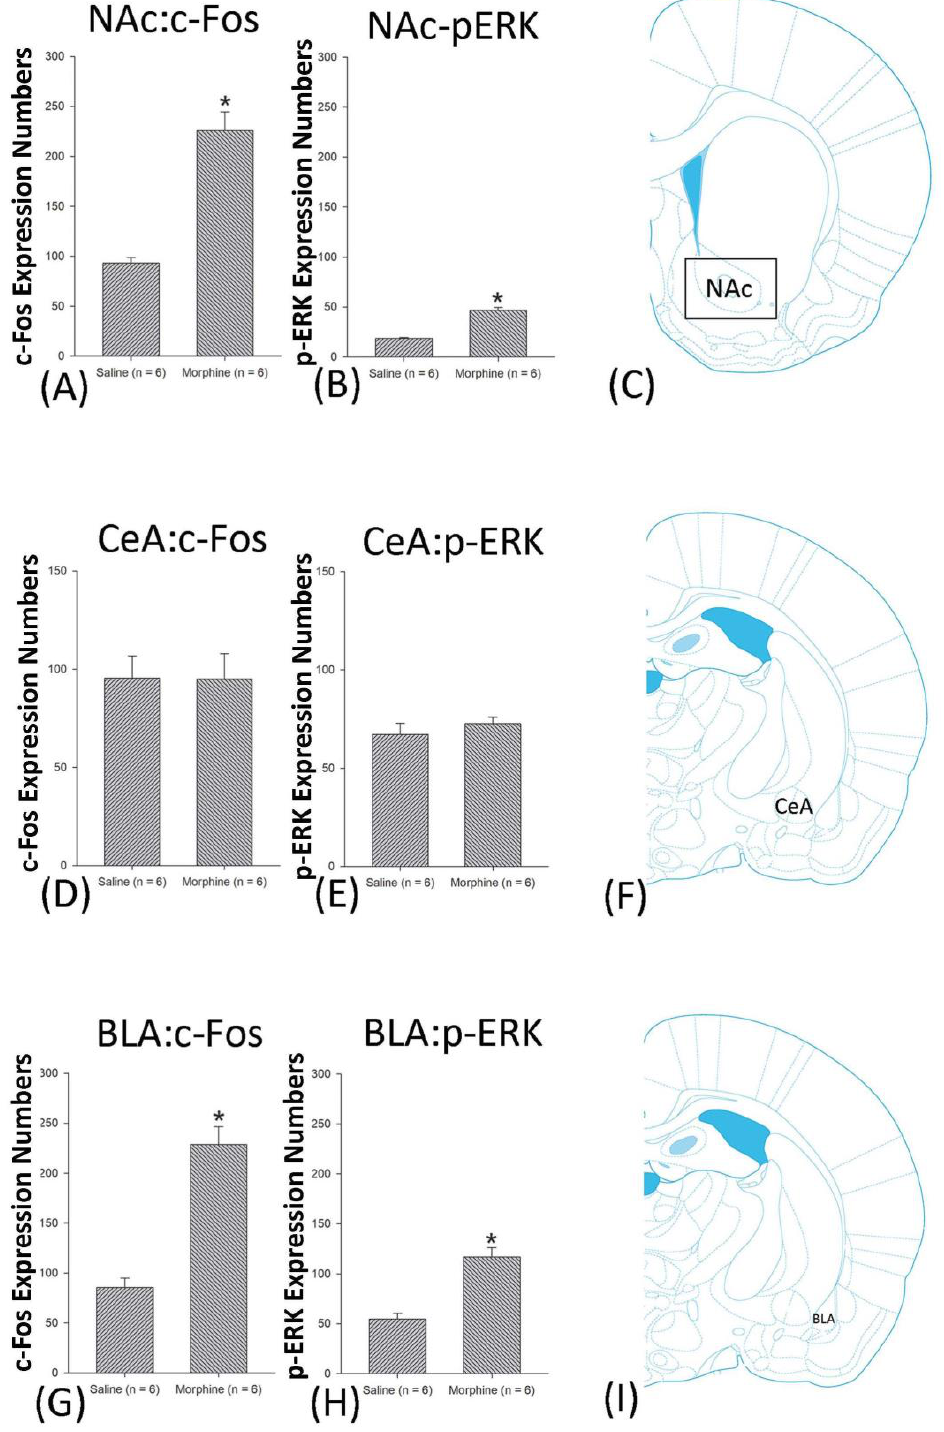
Figure 7. c-Fos or p-ERKimmunoreactivity in the nucleus accumbens (NAc), central amygdala (CeA), and basolateral amygdala (BLA) in conditioning. ( A ) c-Fos expression and ( B ) p-ERK expression in the NAc, ( D ) c-Fos and ( E ). p-ERK expression in the CeA, and ( G ) c-Fos and ( H ). p-ERK expression in the BLA for conditioning. ( C , F , I ) show a schematic representation of the NAc, CeA, and BLA. * p < 0.05 when comparing the saline and morphine groups ( n = 6 per group).